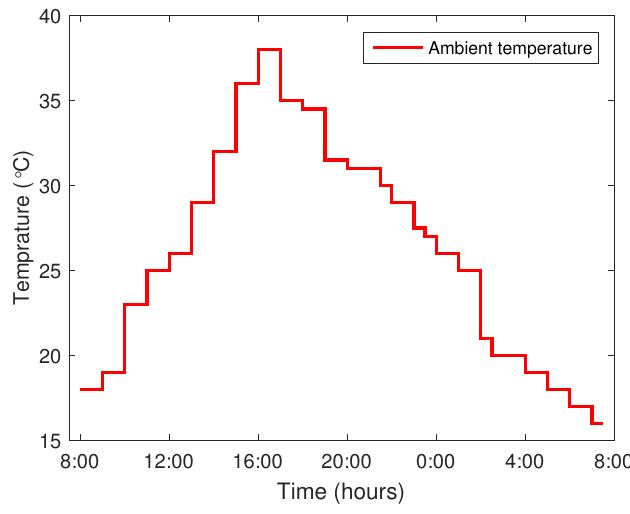
Figure 5. Ambient temperature.